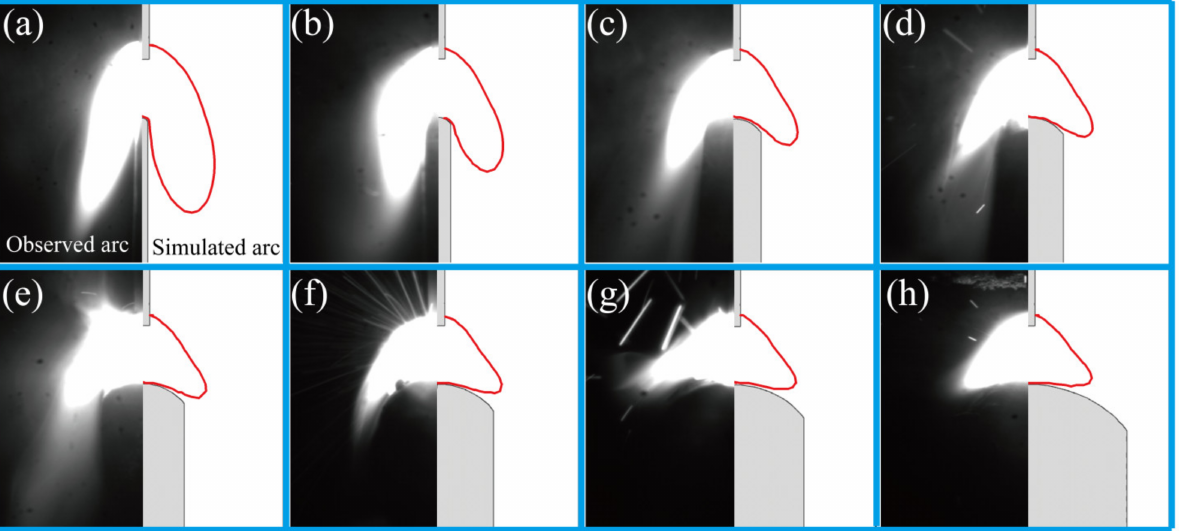
Figure 3. Comparison of the observed and simulated arc profiles at different wall thicknesses: ( a ) δ = 1 mm, ( b ) δ = 2 mm, ( c ) δ = 4 mm, ( d ) δ = 5 mm, ( e ) δ = 6 mm, ( f ) δ = 8 mm, ( g ) δ = 10 mm, ( h ) δ = 14